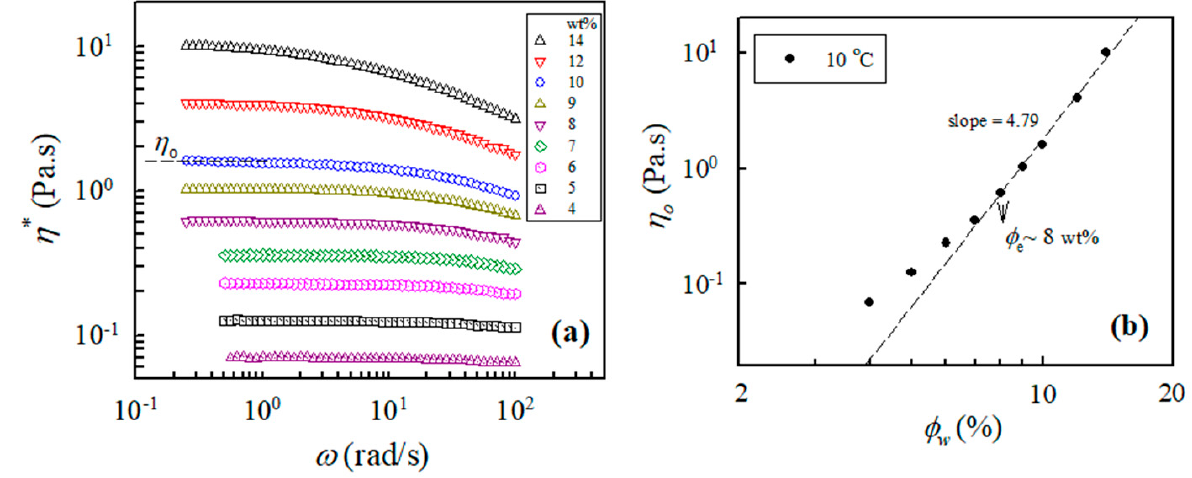
Figure 2. ( a ) Complex viscosity of a-PNIPAM/H 2 O of different concentrations measured at 10 °C; ( b ) log-log plot of η 0 vs. φ w used to determine the entanglement concentration φ e . Figure 3 shows the concentration dependence of η 0 measured at three selected tem- peratures of 10 ◦ C, 20 ◦ C, and 25 ◦ C. As expected, η 0 increased with increasing polymer concentration at a given temperature, and η 0 was larger at 10 ◦ C than that at 20 ◦ C. How- ever, at 25 ◦ C, an anomalous increase in solution viscosity was seen for solutions with a concentration higher than 6 wt%. The solution viscosity of the 9 wt% solutions at 25 ◦